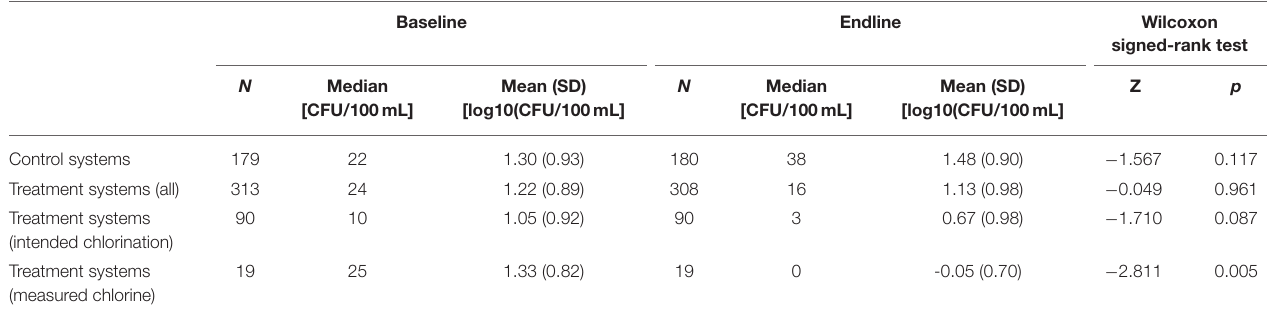
TABLE 1 | E. coli concentration at the point of consumption at baseline and endline in control and treatment systems, including comparison from baseline to endline with the Wilcoxon signed-rank test.